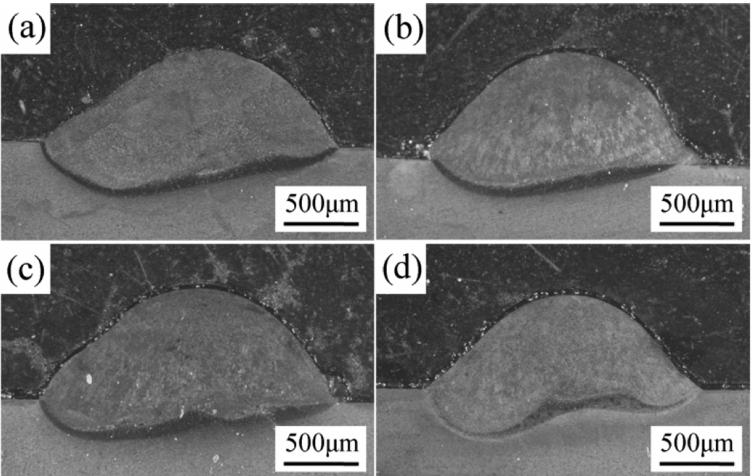
Figure 3: Cross-section of the composite coat- ings: (a) 0%; (b) 2%; (c) 4% and (d)